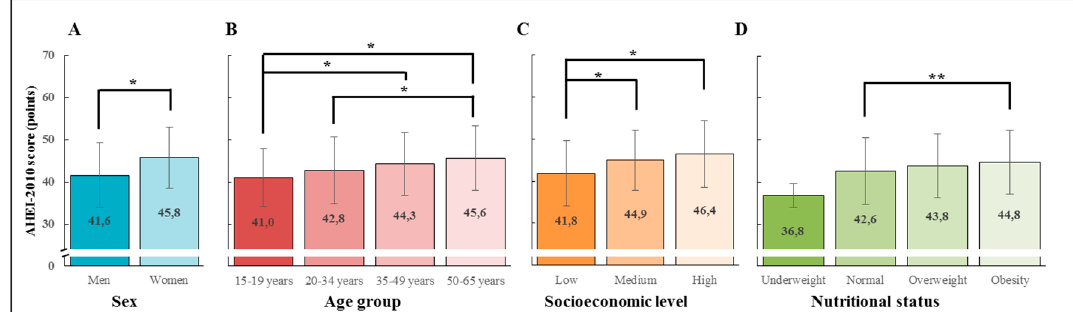
Figure 2. Alternate Healthy Eating Index 2010 scores according to sex, age group, socioeconomic level and nutritional status in Chilean urban population enrolled in ELANS 2014–2015. Mean ± SD scores for AHEI-2010 are shown by sex ( A ), age groups ( B ), socioeconomic level ( C ), and nutritional status ( D ). Differences between groups were considered statistically significant if p < 0.05 using parametric Student’s t -test (for sex) or one-way ANOVA with Bonferroni’s multiple comparisons test (for age groups, socioeconomic level, and nutritional status). * p ≤ 0.001 ** p < 0.05.